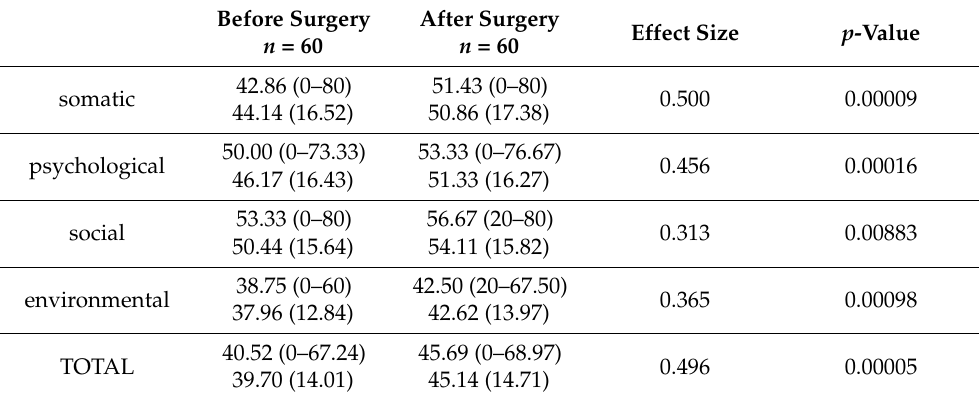
Table 3. Domain scores of the WHOQOL-BREF questionnaire from women before and after surgery. Before Surgery After Surgery Effect Size p -Value n = 60 n = 60